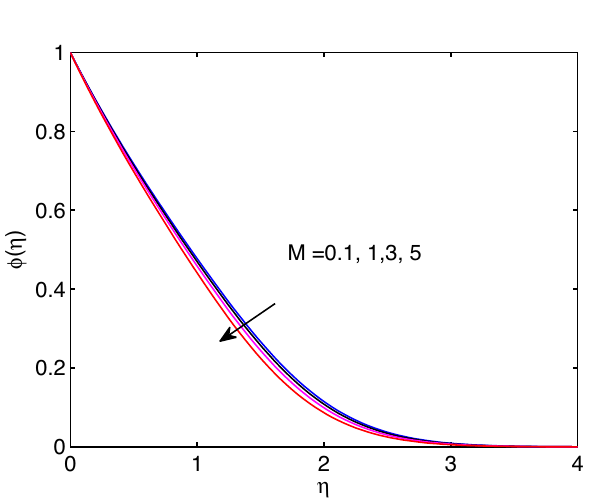
Figure 12. Magnetic field effects on volumetric concentration